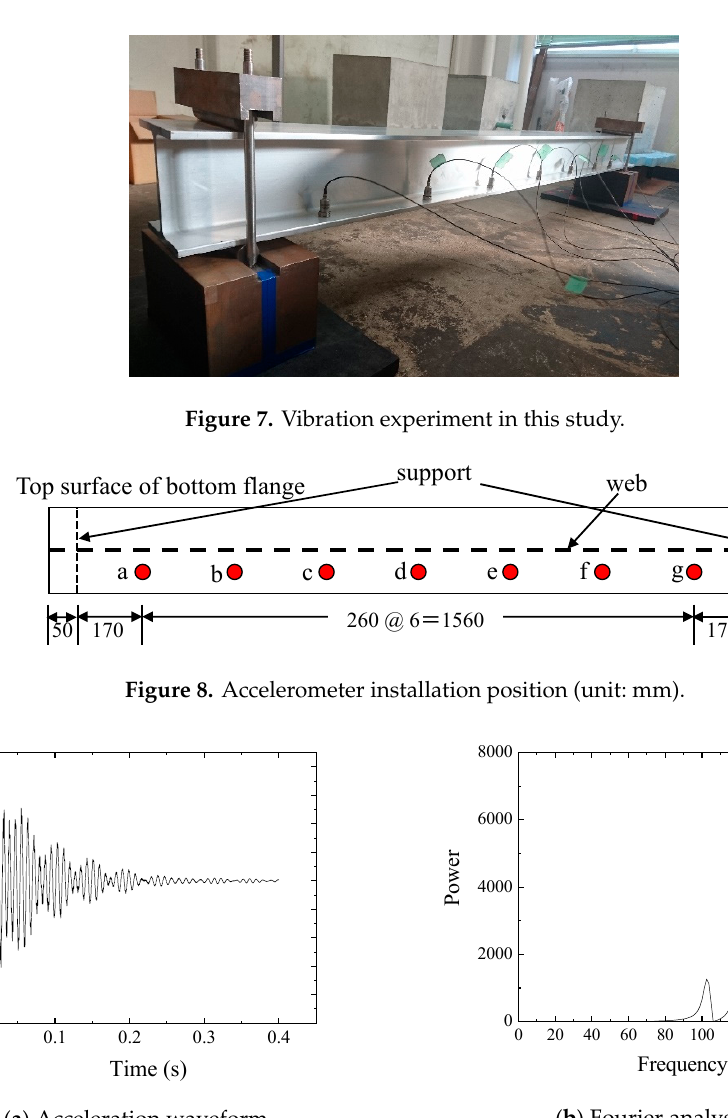
Figure 9. Acceleration waveform and Fourier analysis results of a sound specimen at position d.